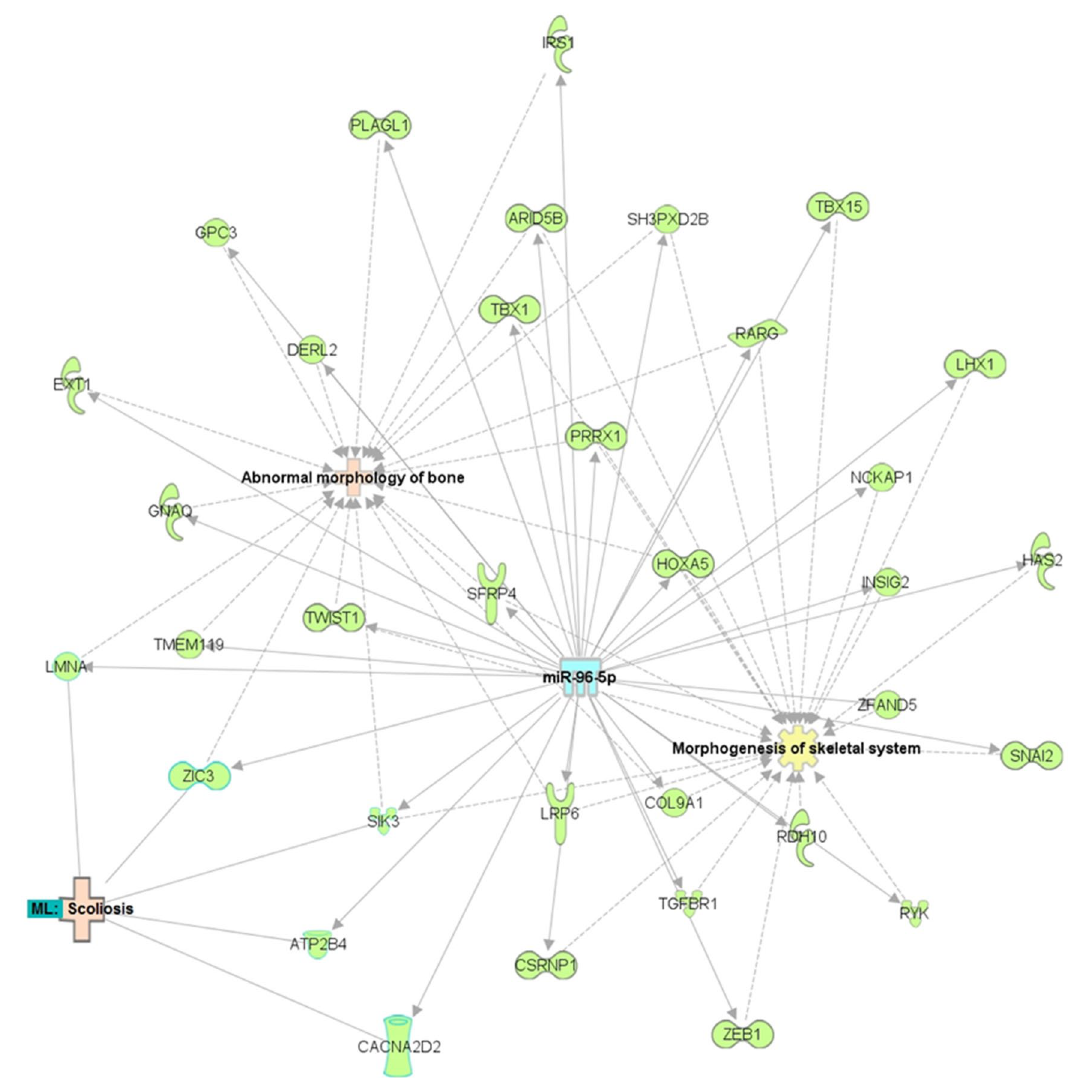
Figure 2. Predicted gene pathways and network of miR-96-5p. The miRNA is represented in blue; the genes that were predicted to interact with each other are in green; the diseases that were predicted to be associated with the miRNA or genes are in light pink; and the molecular and physiological functions are in yellow. The hybrid approach of IPA and manual curations was applied to construct the network of